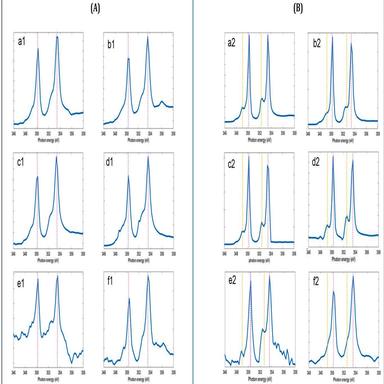
Pure spectral profiles of X-PEEM acquired by MCR-ALS. (A (a1-f1)): before annealing, (B (a2-f2)): after annealing. The purples disconnected lines are for indicating Ca2+ peaks L3 and L2, while red disconnected lines for indicating the new appearing peaks. (For interpretation of the references to color in this figure legend, the reader is referred to the web version of this article.)